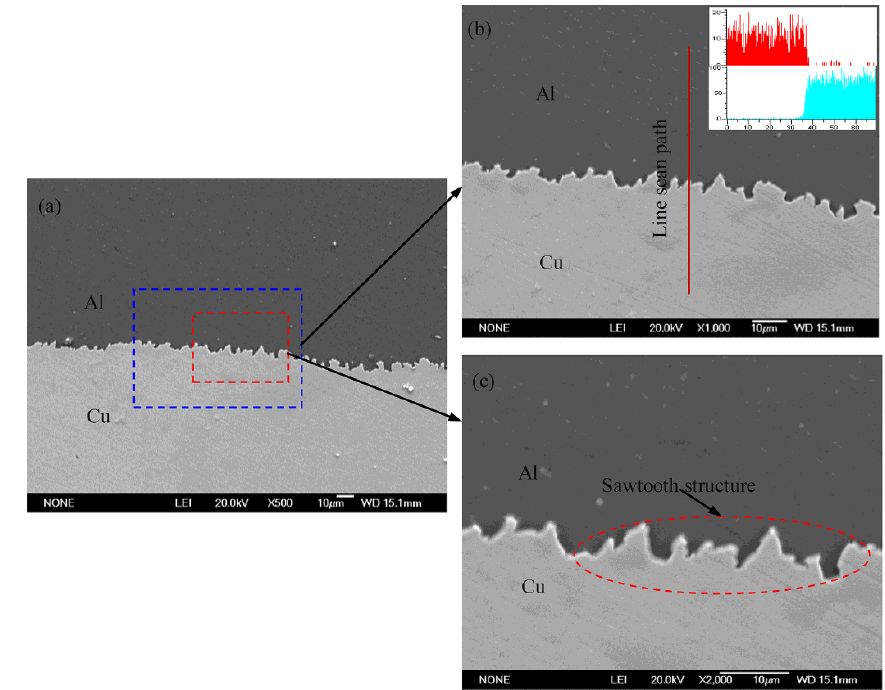
Figure 3. The typical interface morphology of the Cu/Al cathode conductive head produced by cold pressure welding, shown as: ( a ) a typical interface microstructure, ( b ) the elemental distribution of the vertical interface, and ( c ) the sawtooth structure.